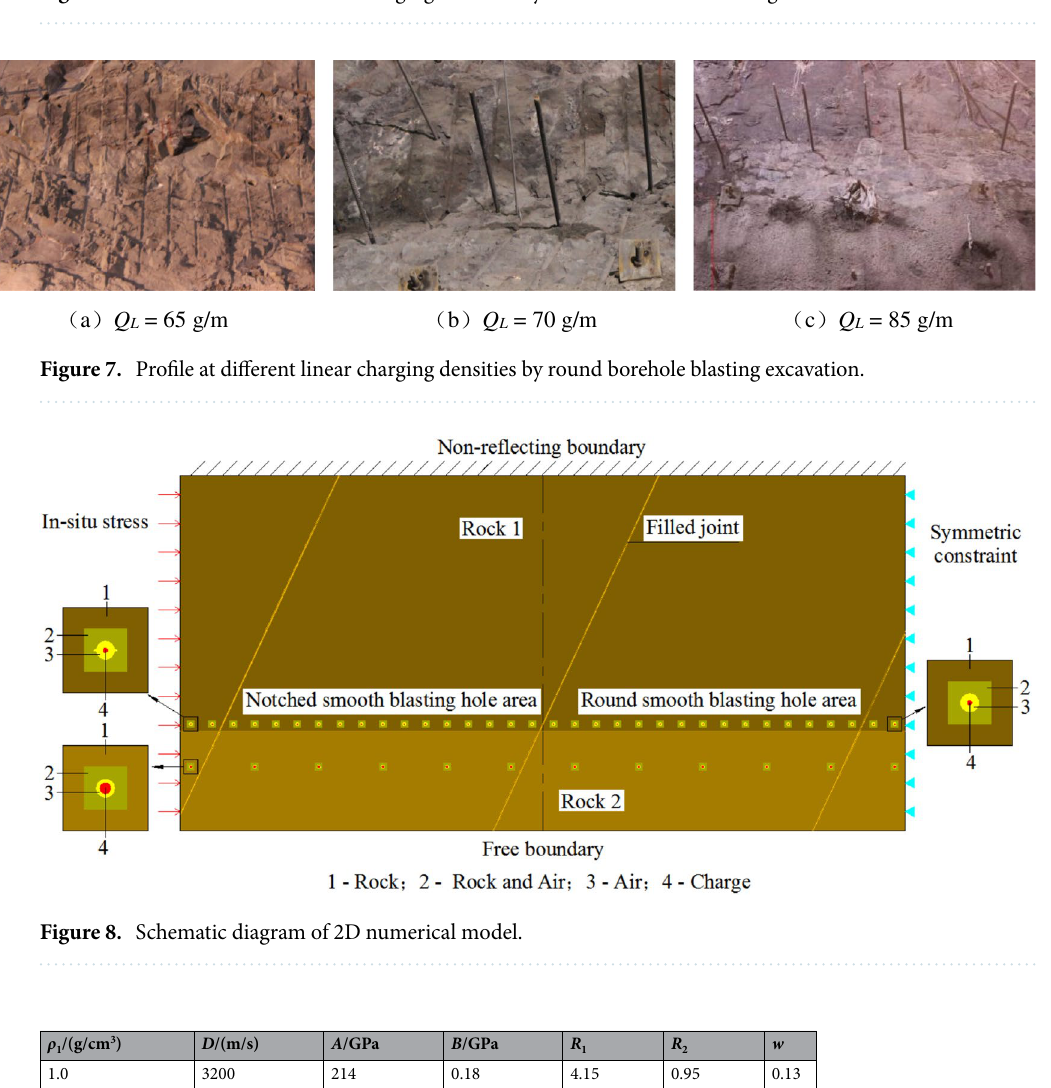
Figure 6. Profile at different linear charging densities by notched borehole blasting excavation.